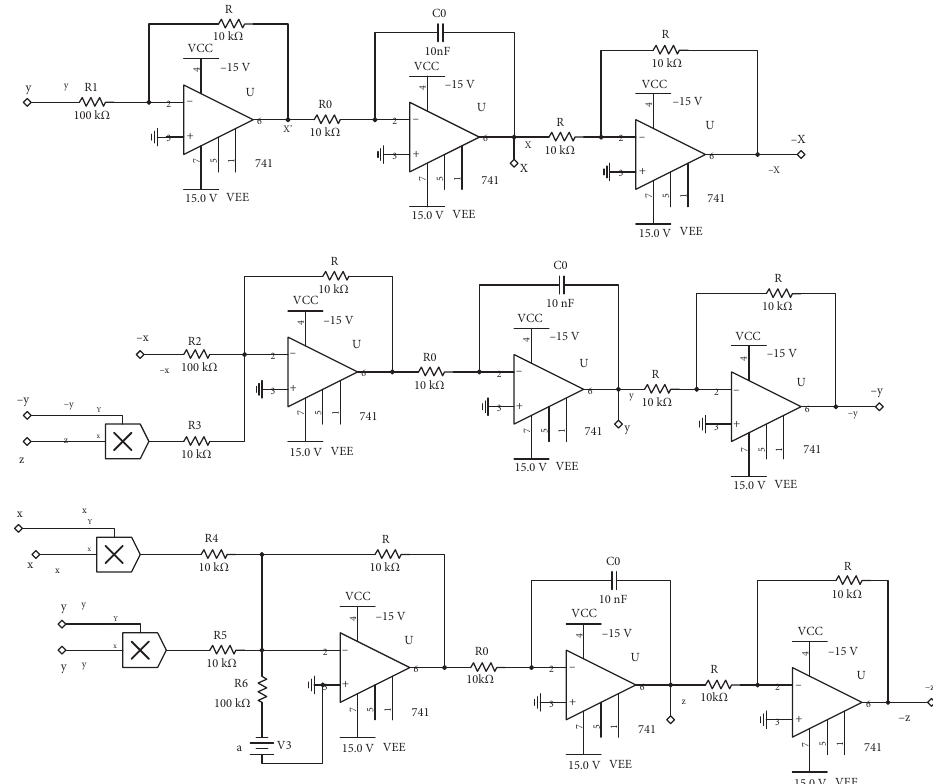
Figure 8: The circuit principle diagram of system (7).